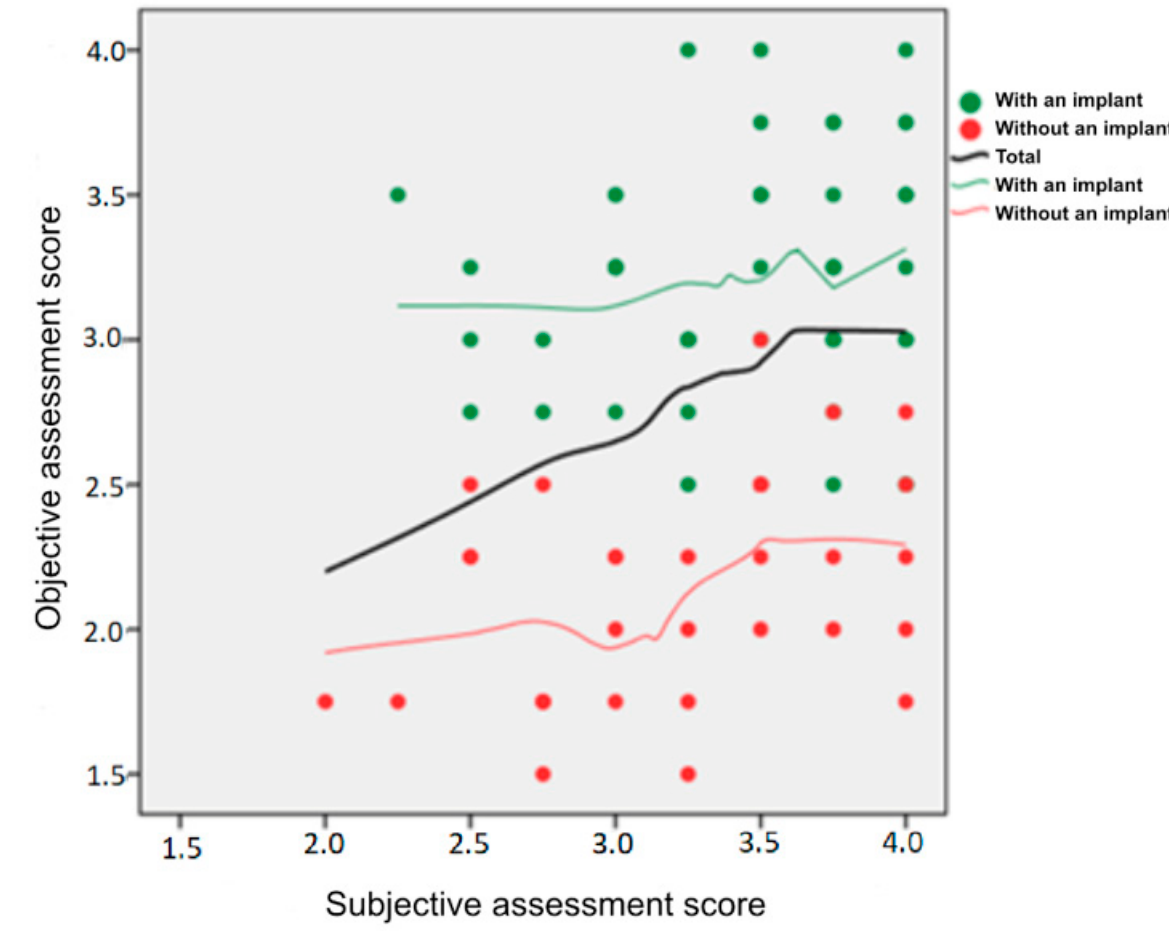
Figure 6. A scatterplot of a correlation between the overall objective and subjective assessment scores in patients with and without an orbital implant. The loess curves represent the mean objective score for a given level of the subjective